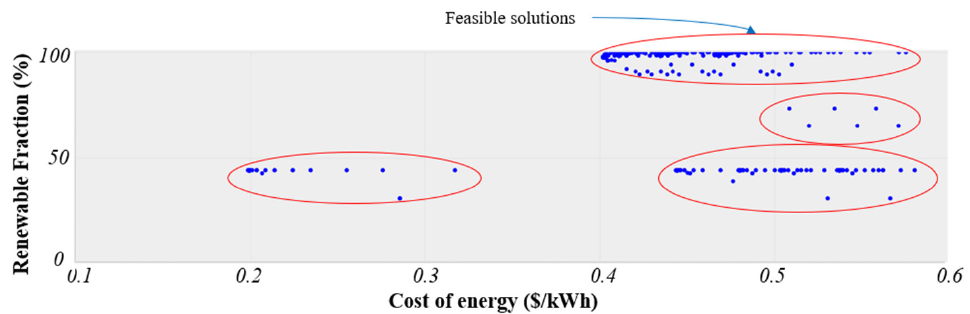
Figure 19. Optimization plot between COE and renewable fraction for 25 years project lifetime.